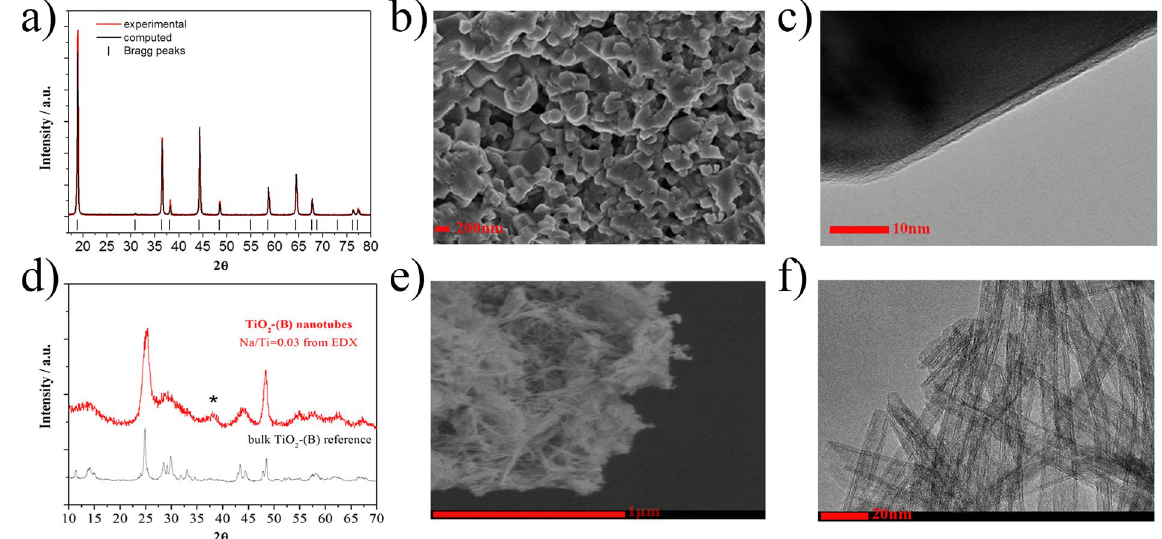
Figure 1. ( a ) XRD pattern, ( b ) SEM and ( c ) TEM micrographies of the LNMO powder. ( d ) XRD pattern, ( e ) SEM and ( f ) TEM micrographies of the TiO 2 -B powder.